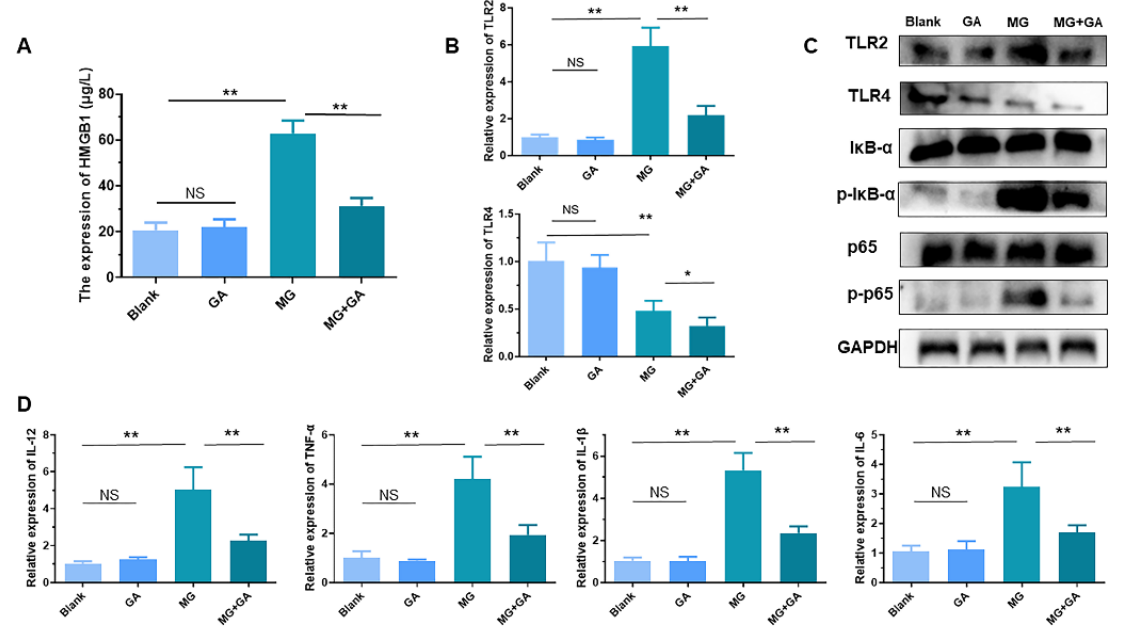
Figure 7. Inhibition of HMGB1 alleviates MG-induced inflammatory damage in spleen tissue. ( A ) The level of HMGB1 in serum was detected by ELISA. ( B , C ) The levels of TLRs and NF- κ B related-genes were detected by qPCR and WB. ( D ) The relative expression levels of TNF- α , IL-1 β , IL-12, and IL-6 mRNA in the spleen tissue. NS p > 0.05. * p < 0.05, and ** p < 0.01 show statistically significant difference compared to the MG group.